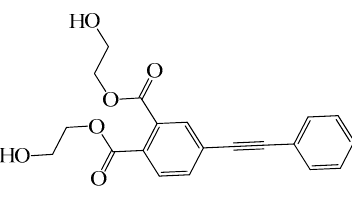
Figure 1. Structure of PEPE.